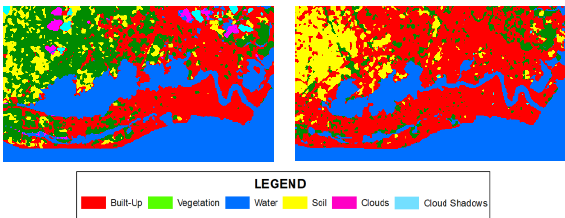
Figure 5. Land cover classification of Iloilo City in 1994